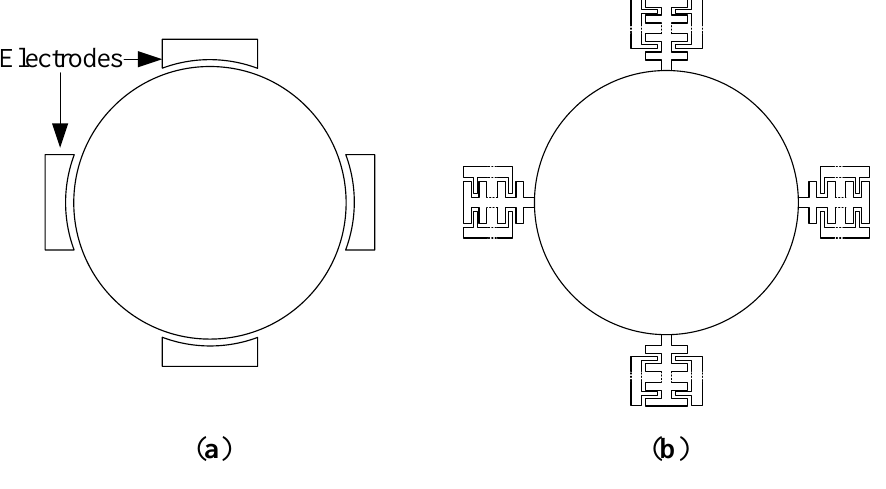
Figure 1. Simplified illustration for the ( a ) typical disk gyroscope, and ( b ) the proposed combined disk-comb gyroscope (electrodes are positioned symbolically around the disk